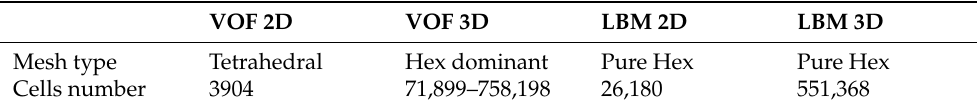
Table 1. Mesh properties of the Volume of Fluid (VOF) and Lattice-Boltzmann (LBM) methods used for the simulations of Section 5.